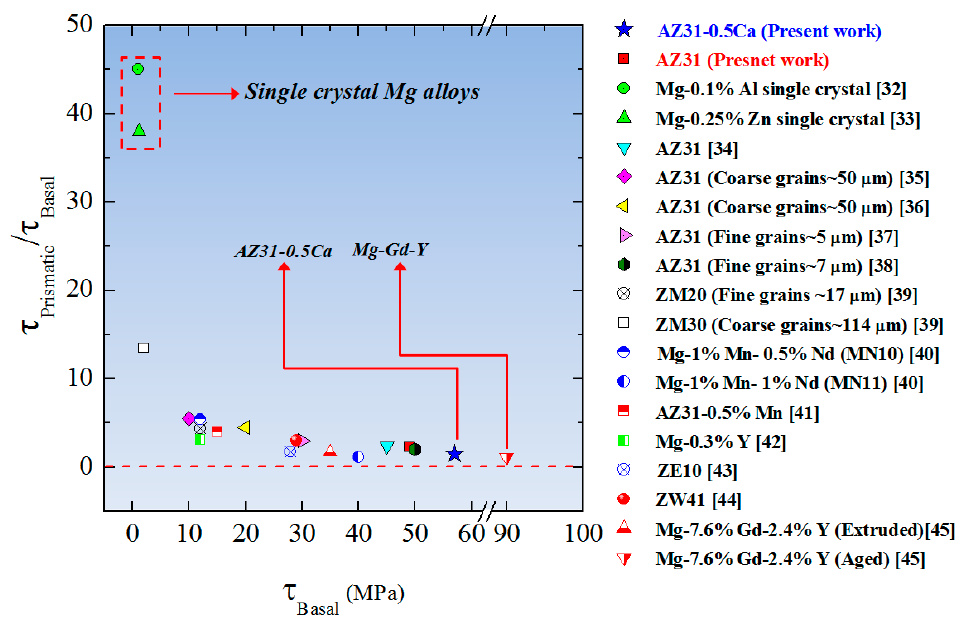
Figure 10. The ratios between the effective CRSSs ( τ Prismatic / τ Basal ) as a function to the effective CRSS of the basal slip for several Mg alloys (single-crystal and polycrystalline) [7]. The CRSSs presented in this figure were determined by using various models including the viscoplastic self-consistent (VPSC) model, the elastoplastic self-consistent (EPSC) model, the elastic viscoplastic self-consistent (EVPSC) model, and the Sachs model.